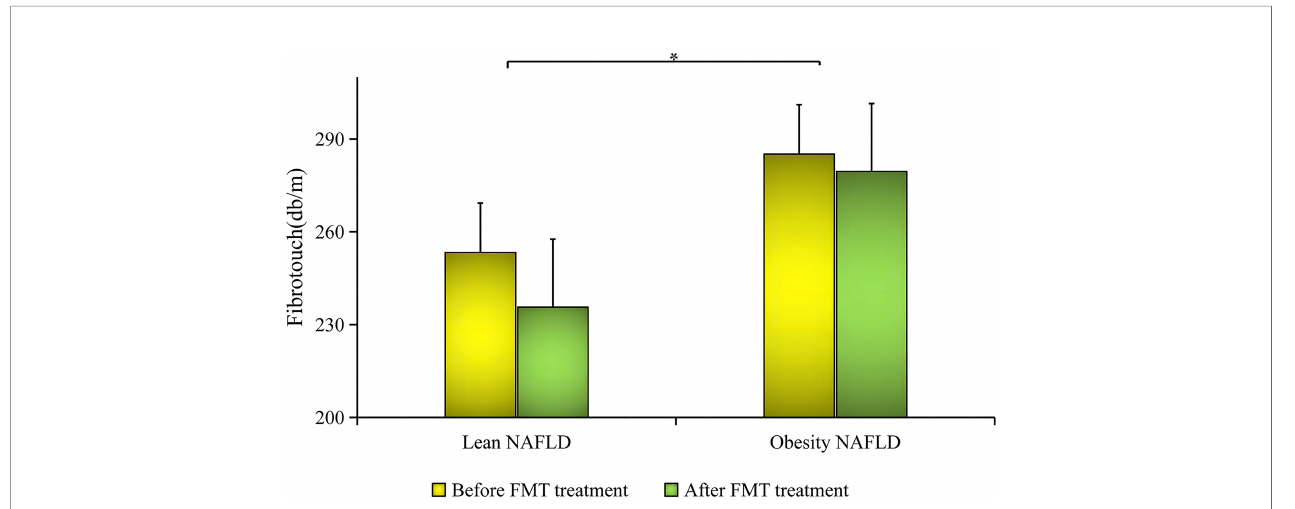
FIGURE 5 | Comparison of the decrease in fat attenuation before and after fecal microbiota transplantation (FMT) between the two groups. * meaning Lean NAFLD vs obese NAFLD had statistical difference, P <